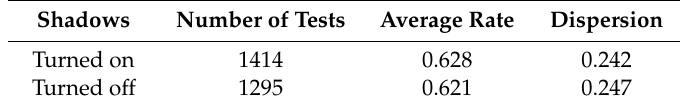
Table A7. Numerical results of the users regarding the shadows in the